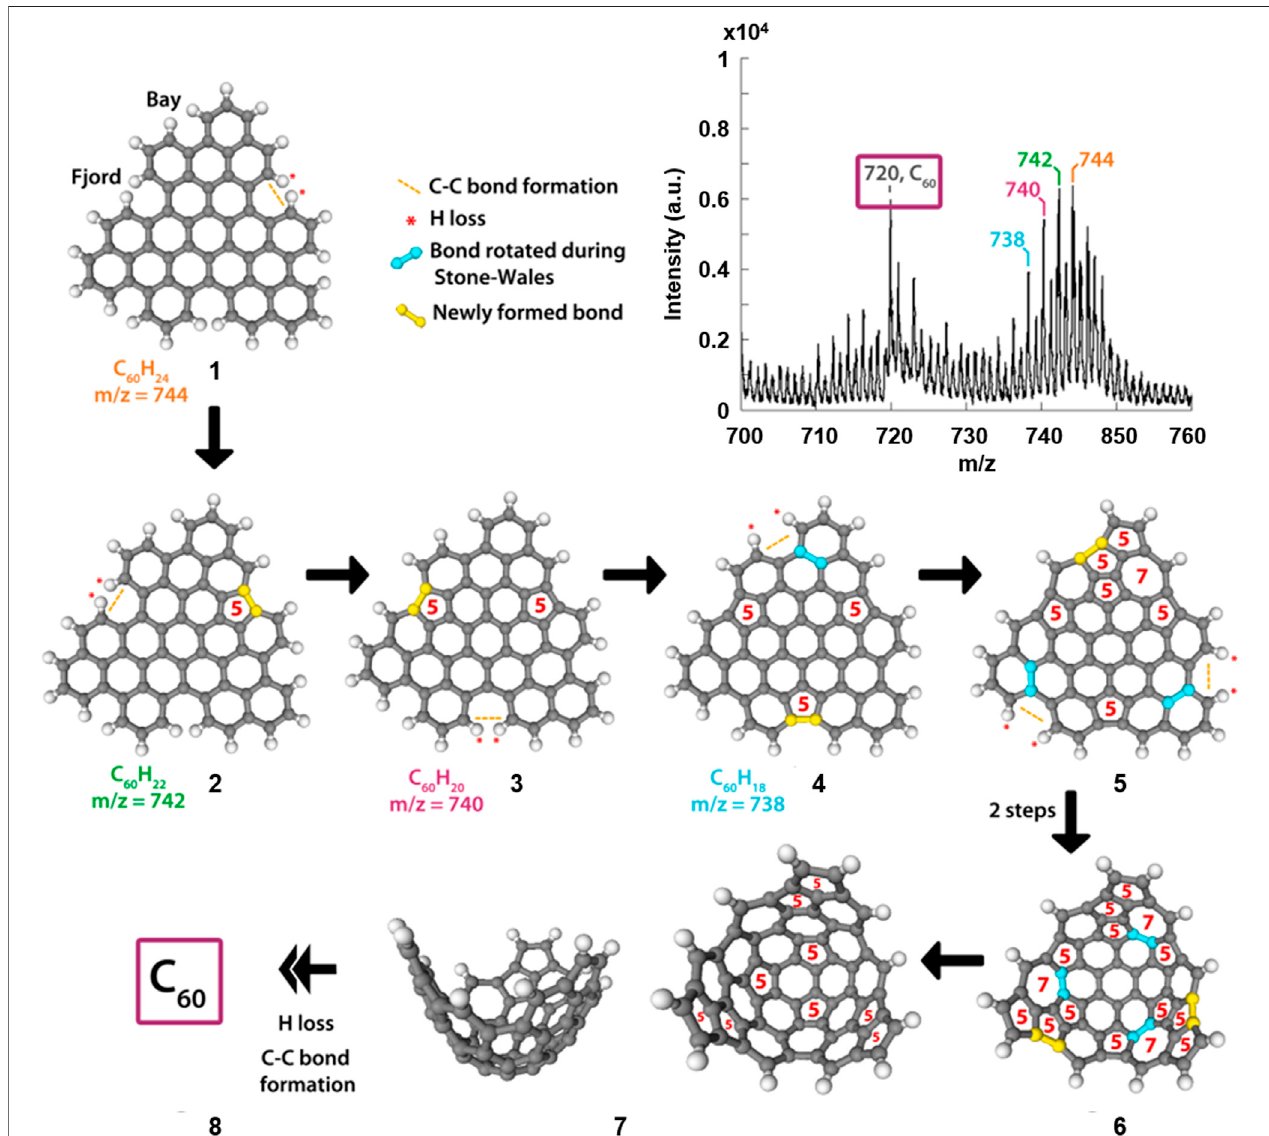
FIGURE3| Sectionofthemassspectrum( Figure2C )resultingfromUVirradiationofperylene(top)andourproposedmechanisticstepsbasedontheMALDI-TOF data and chemical intuition, showing the transformation from the perylene trimer to C 60 . The ring sizes of key parts in the structures are shown in red, and the rotated bonds and newly formed bonds are highlighted in blue and yellow